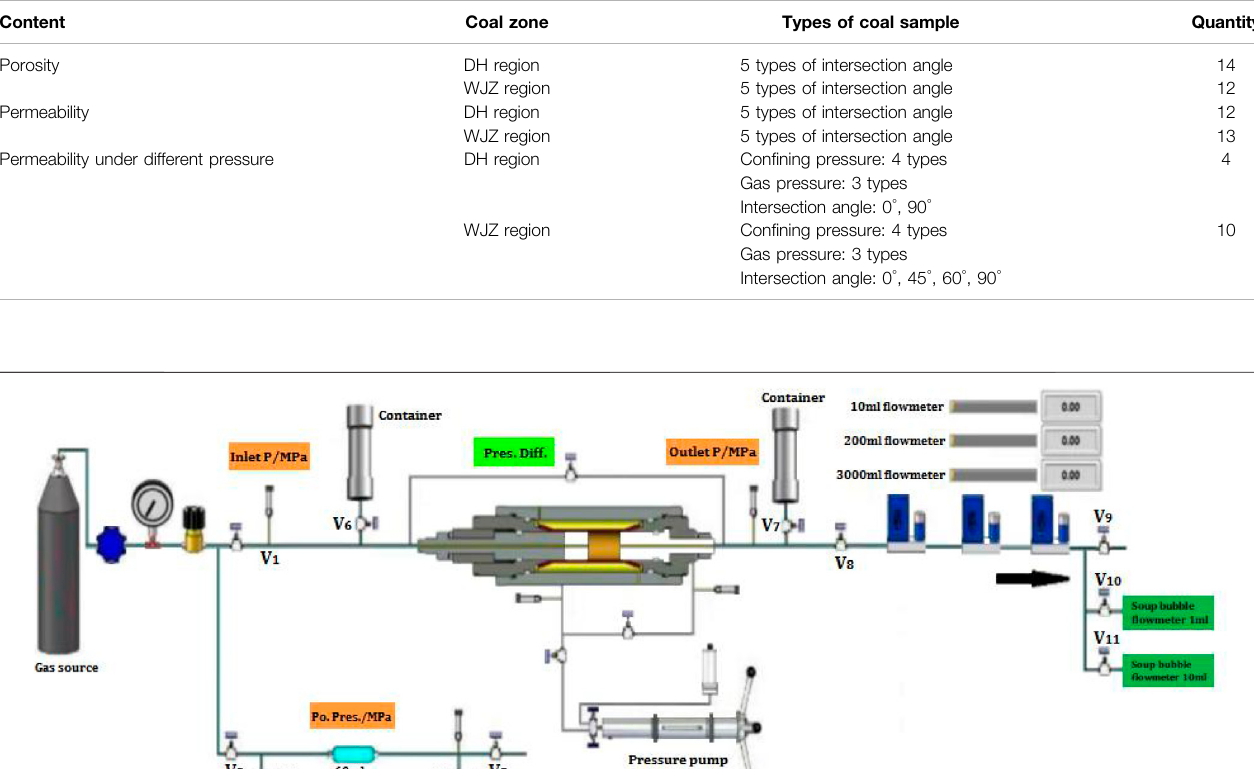
TABLE 1 | Porosity and permeability testing scheme.